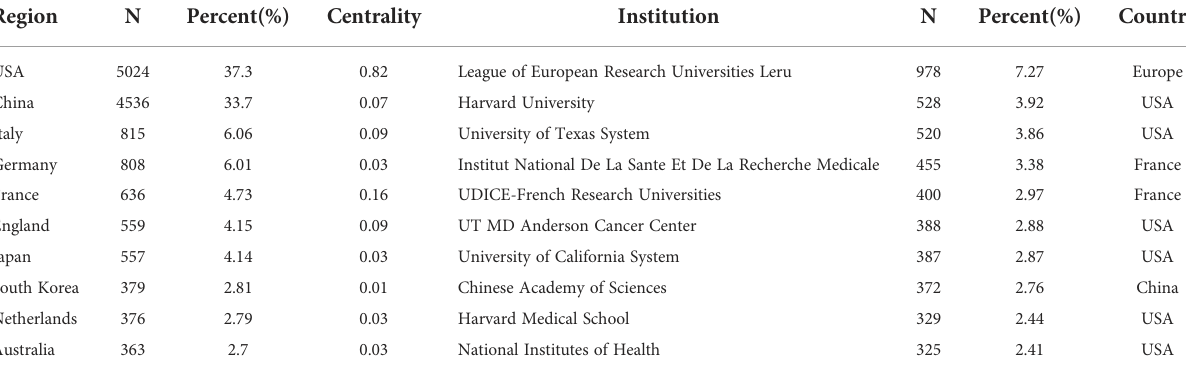
TABLE 3 The top 10 countries/regions and institutions involved in immunotherapy-TME-related research. Region